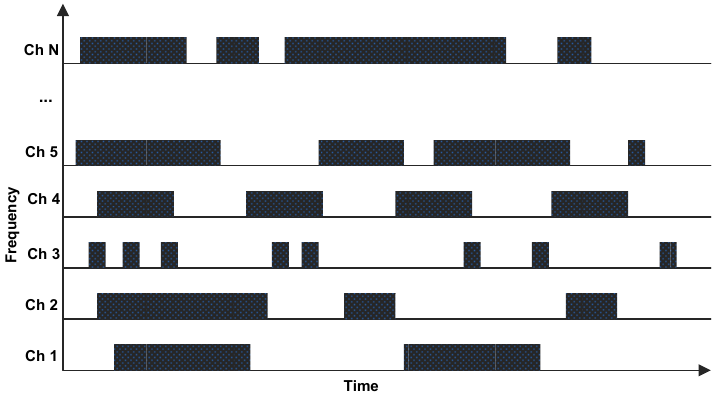
Figure 1. Primary user (PU) behavior on licensed